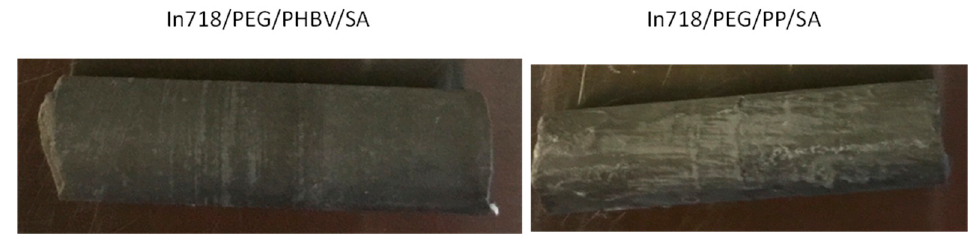
Figure 8. Images of the different samples after 4 h at 150 °C and 400 bar of supercritical CO 2 debinding.